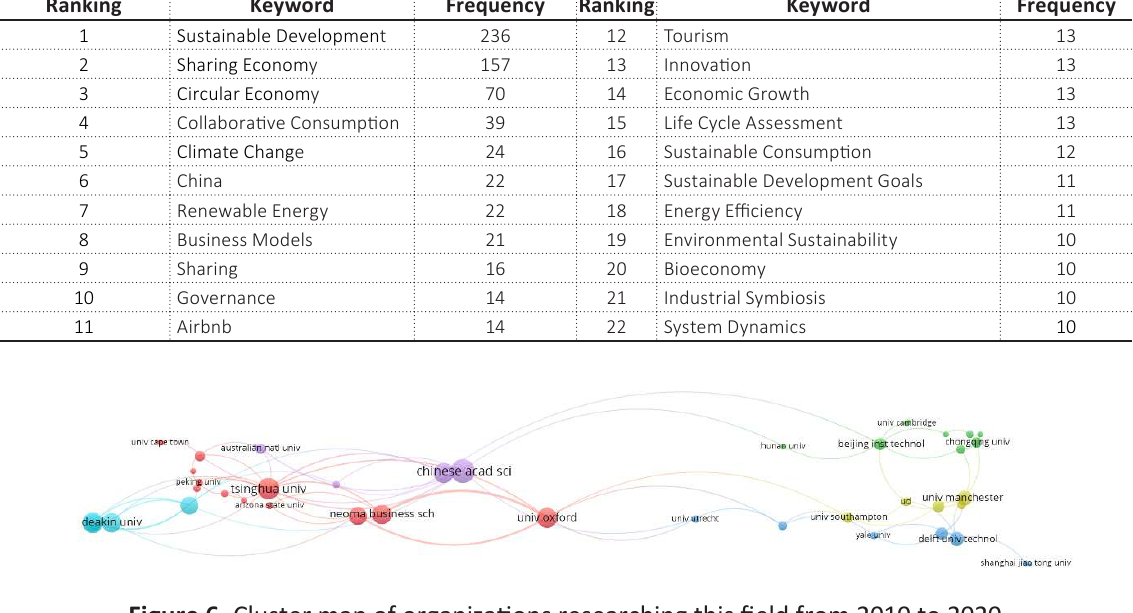
Table 5. High-frequency keywords on sustainable development in the sharing economy from 2010 to